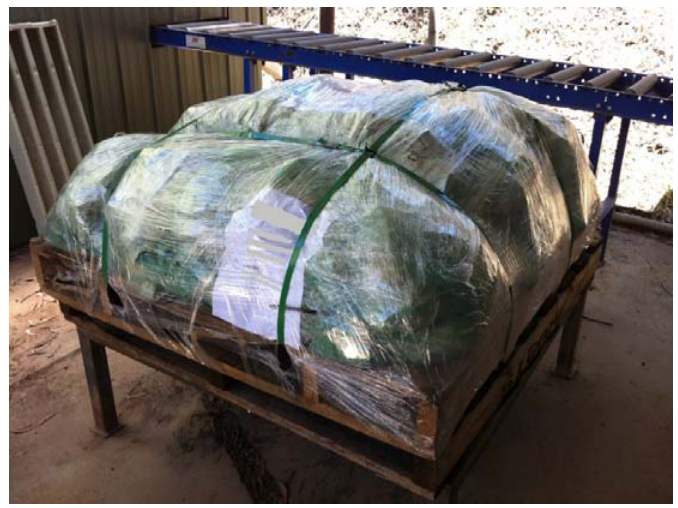
Figure 6. Bagged and sealed metallurgical samples packed for road transport to prevent spillage and